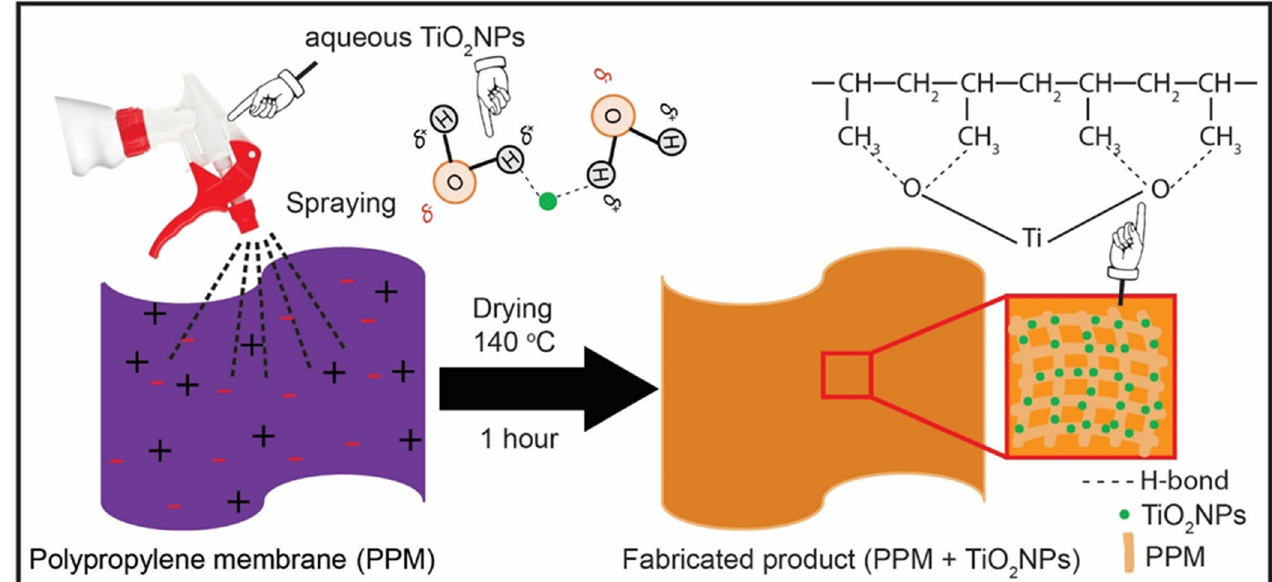
Figure 1. Schematic photograph for the fabrication of the PPM using TiO 2 NPs.